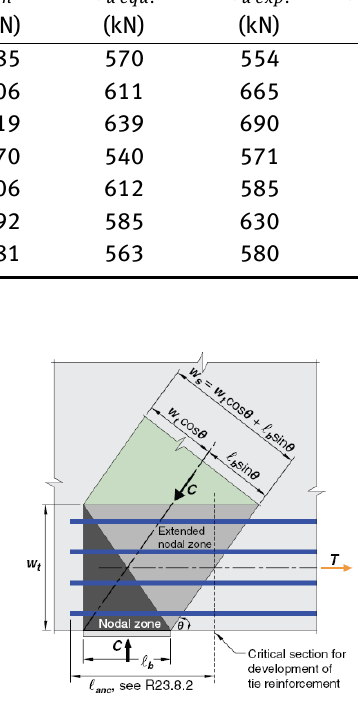
Figure 22: Reinforcement distribution